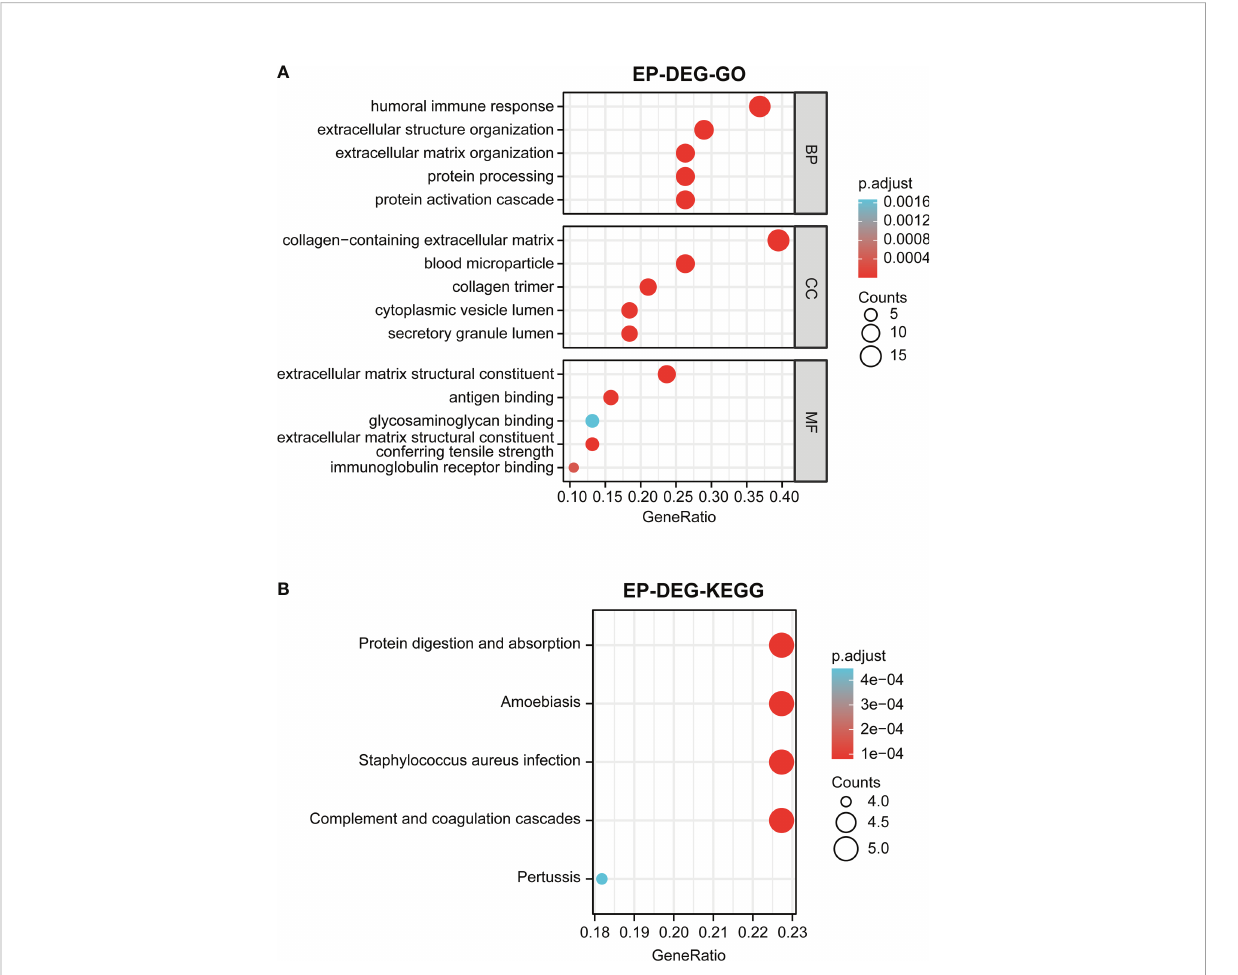
FIGURE 4 Function enrichment analysis of EP-DEGs. (A) GO enrichment analysis of EP-DEGs in BP, CC, and MF processes (BP, biological process; CC, cellular component; MF, molecular function). (B) KEGG enrichment analysis of EP-DEGs. The size of the circles indicates the number of genes. The larger the circle, the greater the number of